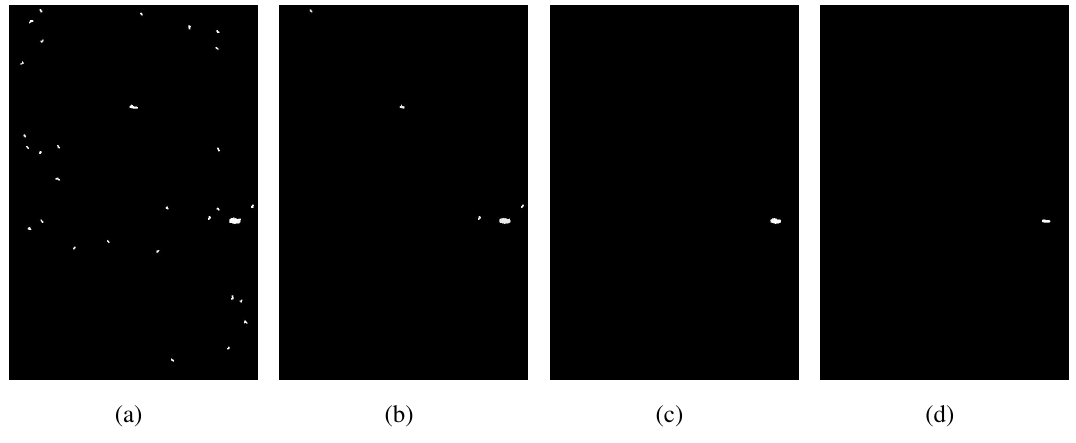
Figure 8. Experiment of foreground on different δ , foreign substance with the biggest